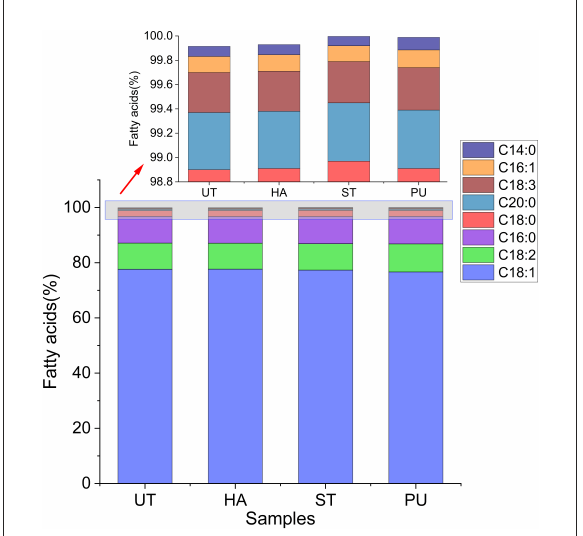
FIGURE3 Fatty acid composition of camellia oils from untreated and HA, ST, PU pretreated camellia seeds.